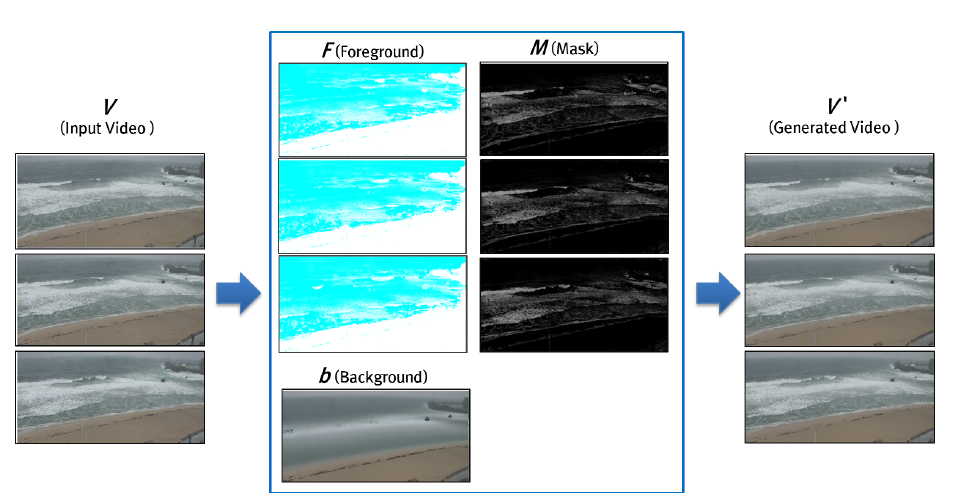
Figure 4. Image sequences of separated scenes ( F , M , b ) from input video sequences ( V ) and generated video sequences ( V (cid:48) ) by combining separated scenes ( F , M , b